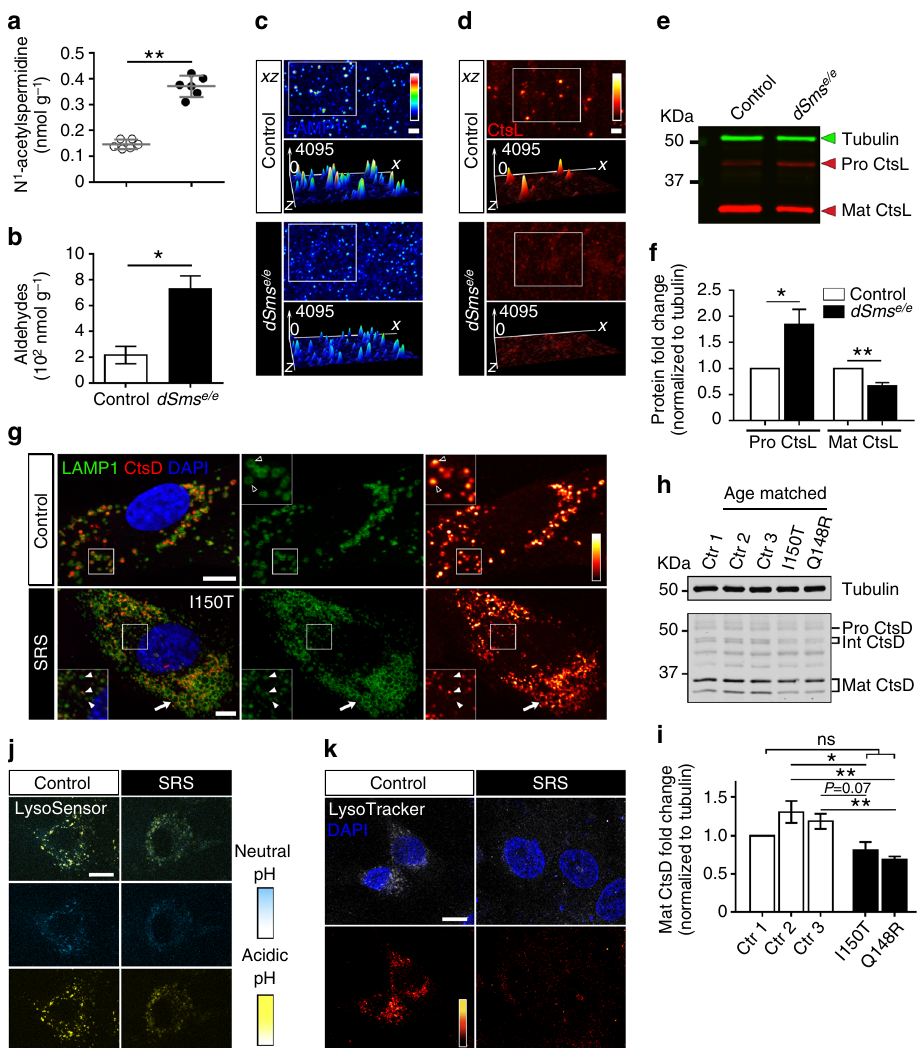
Fig. 5 Spermidine oxidation impairs lysosome integrity and function in dSms mutant synapses and SRS fi broblasts. a N 1 -acetylspermidine level (mean ± 95% CI) measured from young fl ies (2 – 4 DAE) using LC-MS/MS. b Aldehyde content (mean ± S.E.M.; each data point obtained from one extraction of 20 animals, n = 3) measured from third instar larvae using a colorimetric method. c , d Immunostaining of fl y laminae labeled with LAMP1 for lysosome membrane and cathepsin L for lysosomal protease. The fl uorescence intensity pro fi le is illustrated in a three-dimensional surface plot. LAMP1 ( c ) and cathepsin L ( d ) puncta staining intensity is compromised in mutant fl ies. e , f Western analysis of fl y heads ( e ) and quanti fi cation ( f mean ± S.E.M.; each data point obtained from one extraction of 10 animals, n = 7 extractions) showing pro- and mature forms of cathepsin L normalized to tubulin control. Full size blots with molecular weight markers are included in Supplementary Fig. 6. g Immunostaining of age-matched control and SRS fi broblasts labeled with LAMP1 and cathepsin D. Note both enlarged (arrow) and fragmented (white arrowhead) LAMP1 pattern presented in SRS fi broblasts. h , i Western blot analysis of human fi broblasts ( h ) and quanti fi cation ( i mean ± S.E.M.; each data point obtained from one extraction, n = 5 extractions) showing pro-, intermediate, and mature forms of cathepsin D in SRS fi broblasts with two different mutations compared with control fi broblasts. Full size blots with molecular weight markers are included in Supplementary Fig. 6. j , k Live imaging of LysoSensor yellow/blue probe ( j ) and LysoTracker red probe ( k ) in human fi broblasts. Student ’ s t test. * P < 0.05, ** P < 0.01. Scale bar, c , d , 2 µ m; g , j , k , 10 µ